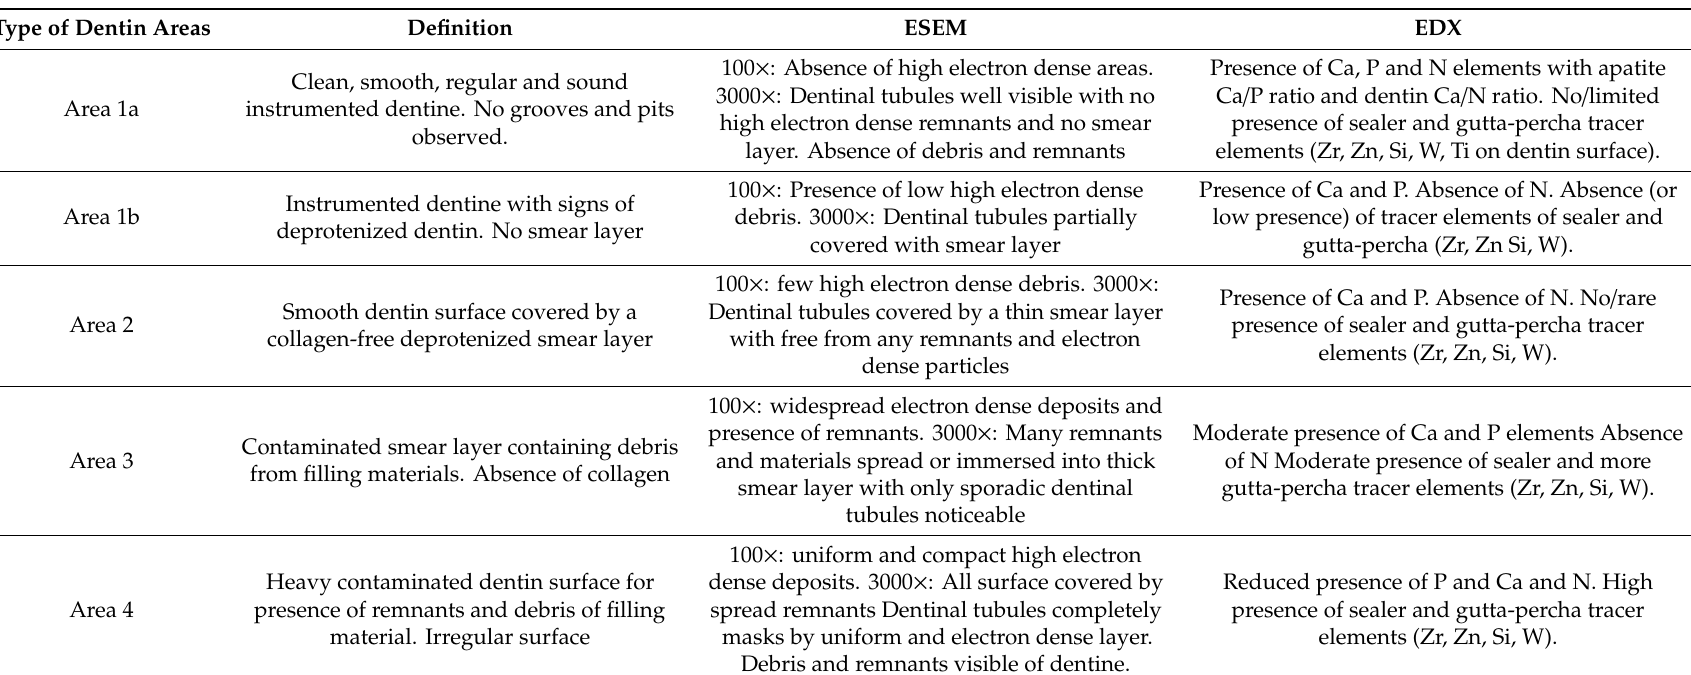
Table 4. Definition of dentine